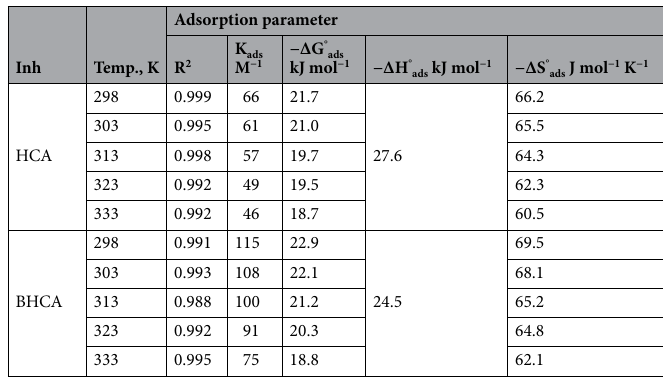
Table 4. Adsorption parameters of HCA and BHCA on CS substrate in 1 M HCl.